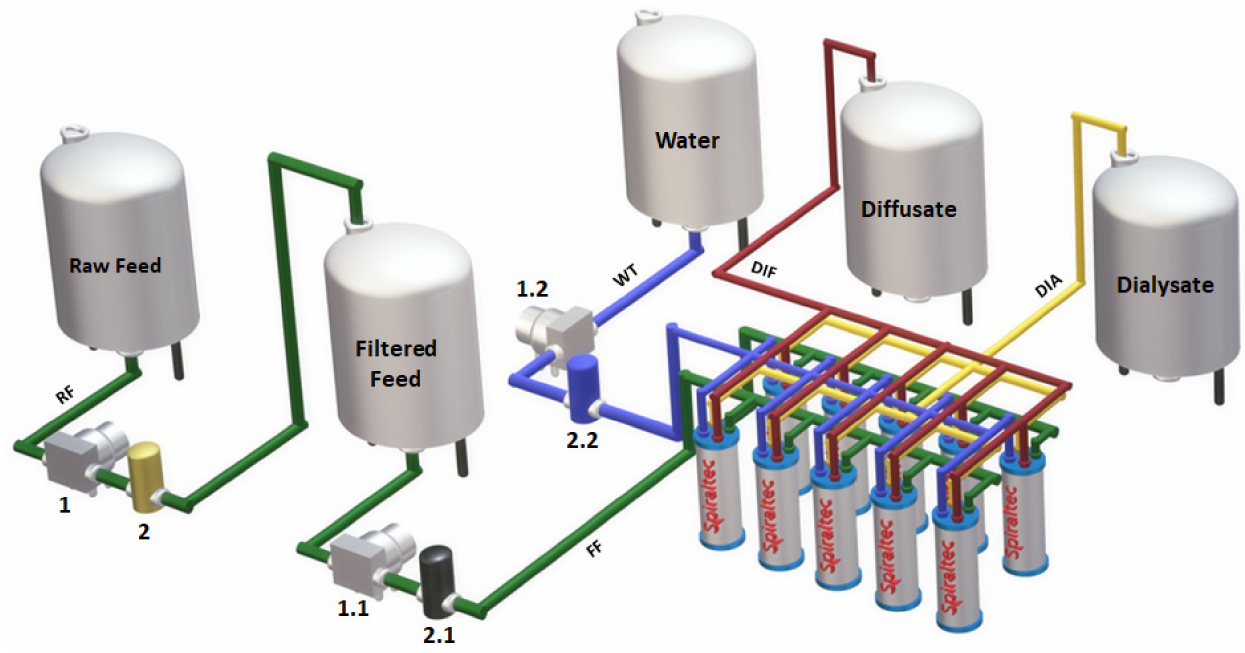
Figure 8. Visualization of the acid-recovery system. Instrumentation key: (1; 1.1; 1.2) pumps; (2; 2.1; 2.2)